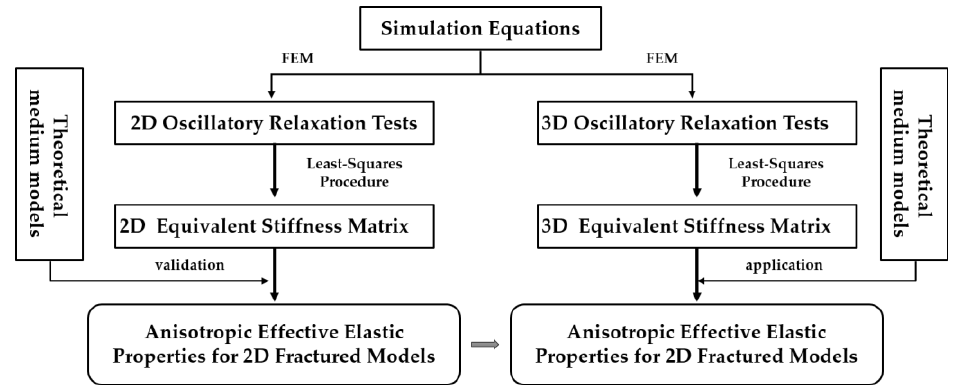
Figure 1. Flowchart of the modeling methodology.